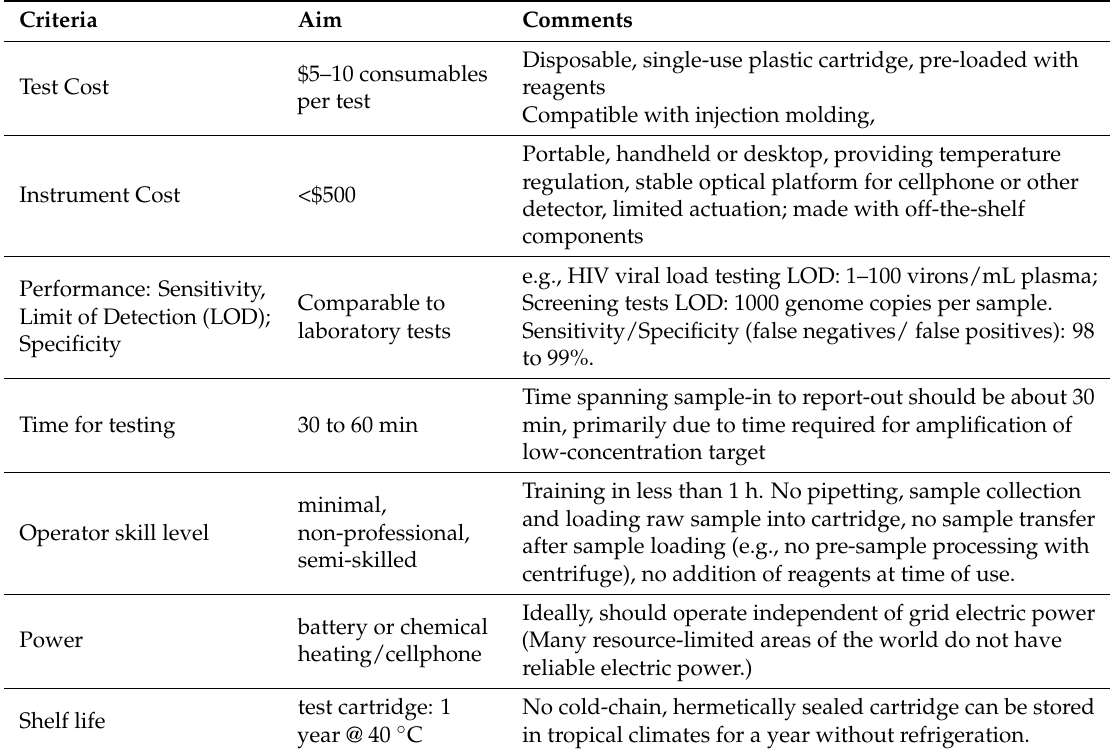
Table 1. Performance and features objectives for point-of-care (POC) nucleic acid amplification